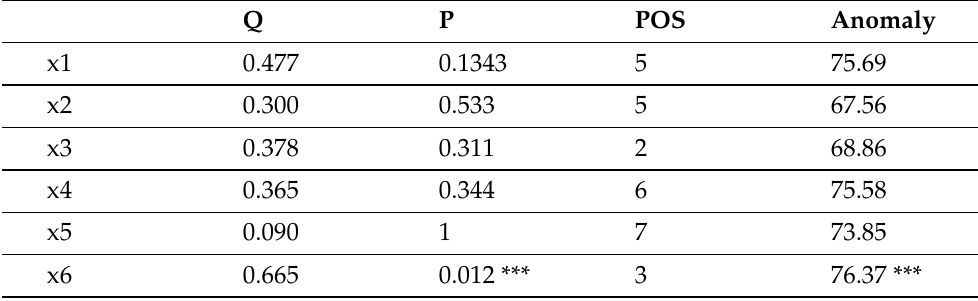
Figure 4. IoTDixon cumulative distribution function of x1, x2, x3, x4, x5, and x6 dataset (from top-left row-wise). Table 1. IoTDixon aware anomaly